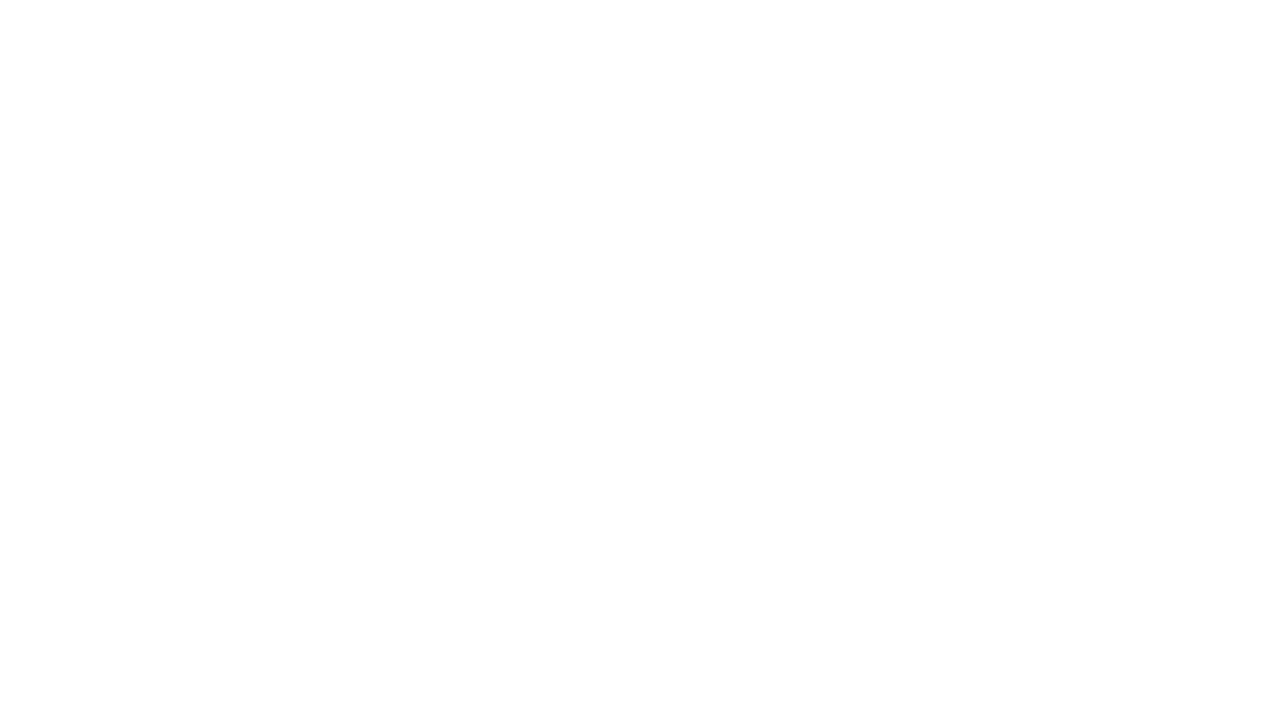
Frontiers in Built Environment |